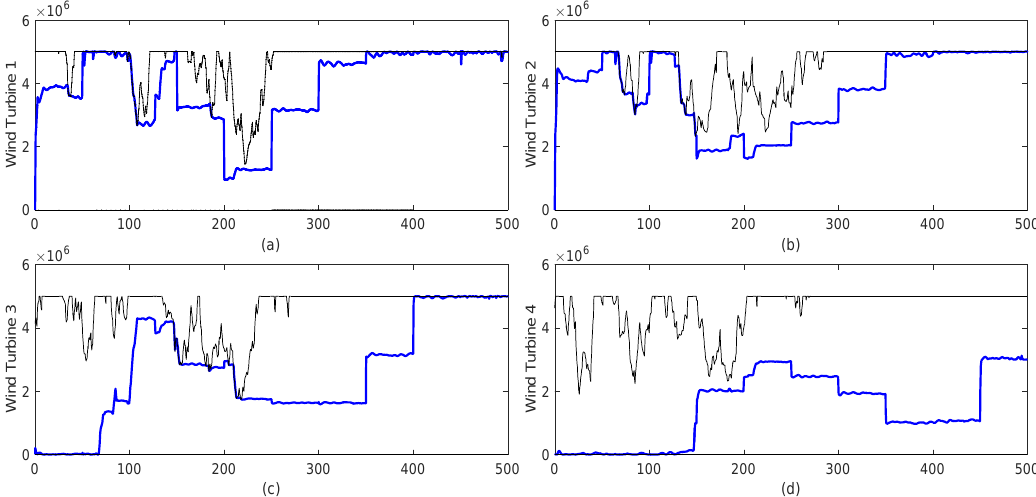
Figure 4. Active power output of each wind turbine under step power demand, sub-figures a, b, c, d are the active power output for wind turbine 1, 2, 3, 4